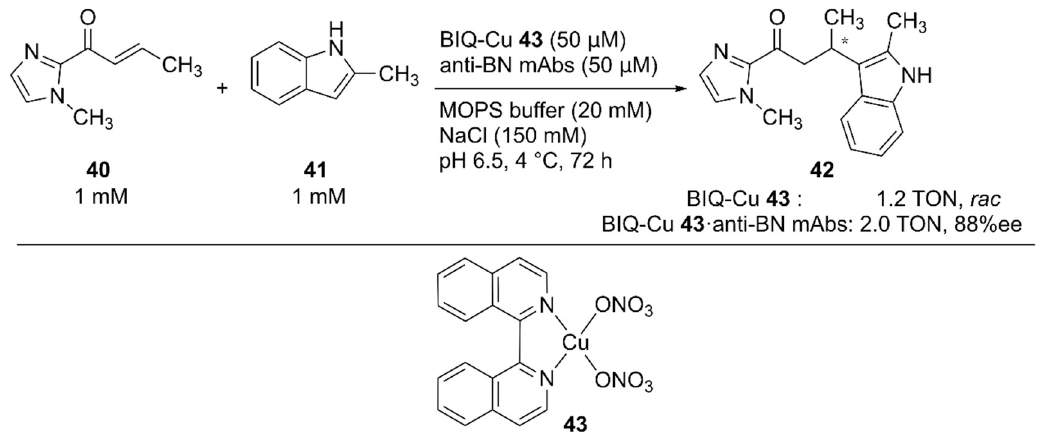
Figure 8. Friedel–Crafts reaction catalyzed by BIQ-Cu 43 · anti-BN mAbs. Adapted from [66].